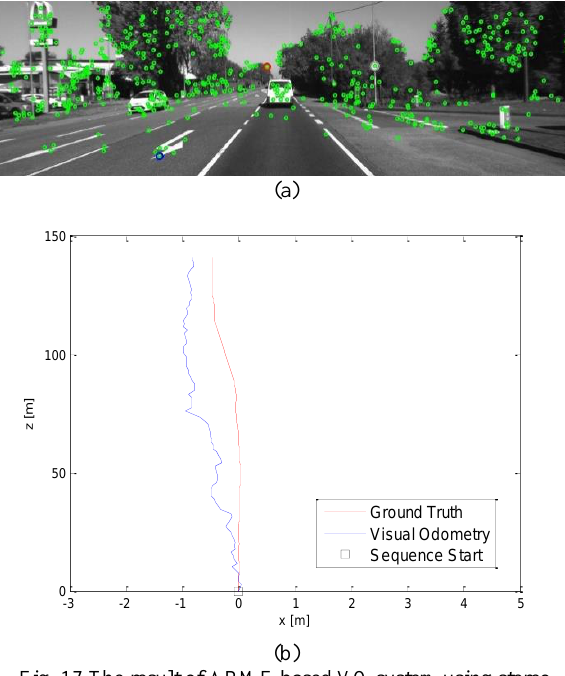
Fig. 17 The result of ARMF-based VO system using stereo images download from KITTI dataset. (a) An image used to show the feature points. In this image, the green circle represent the feature points which have been matched, the blue circle represents the nearest feature point and the red circle represents the farthest one. (b) The comparison of two trajectories. The red line represents the ground truth, the blue line represents the path calculated by the ARMF-based VO system, and the black point represents the start